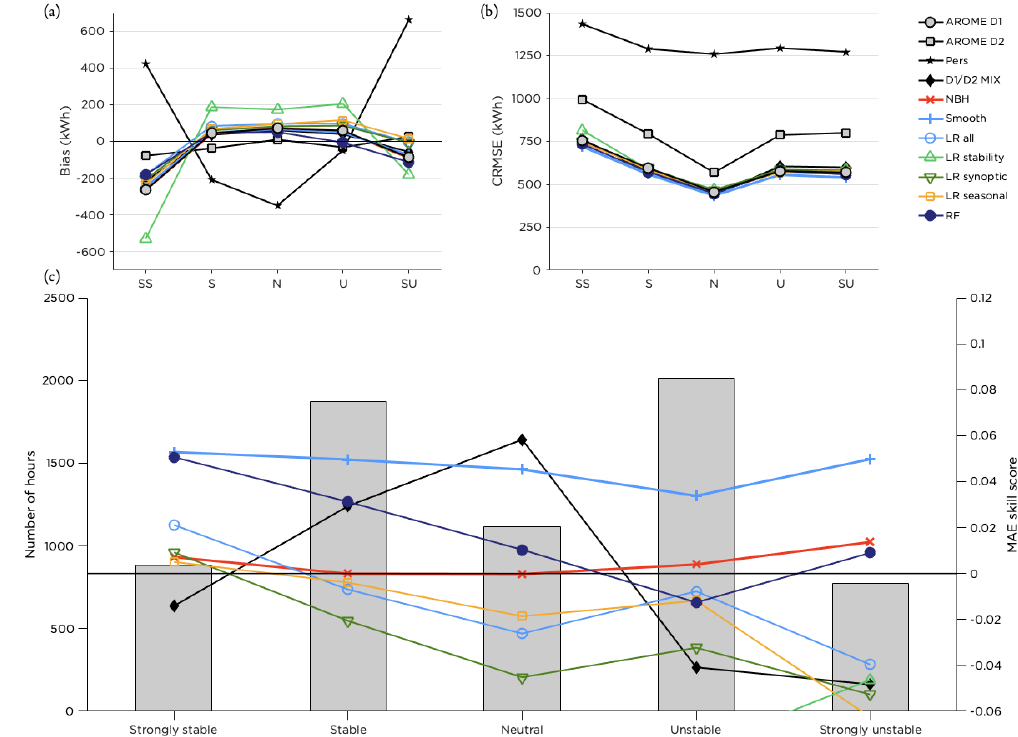
Figure 10. Performance of the post-processing methods for different stability classes. Panel (a) shows the bias, panel (b) the CRMSE and panel (c) the MAE skill score for the methods with the highest scores together with the distribution of the number of hours within each stability class during the test